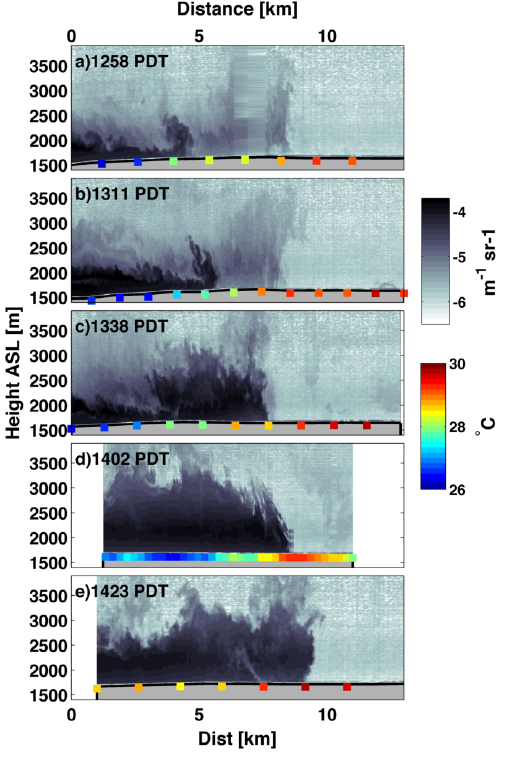
Figure 2. Lidar backscatter (shading, m − 1 sr − 1 ) and near-surface temperature (colored squares) for density current intercepts A–E. Times, in PDT, correspond to the center of the time range in each panel. The data for intercept D were recorded while the truck was stationary, but have been mapped to the spatial coordinate using the estimated frontal speed of 4.6ms − 1 . All distances are relative to an arbitrary point.